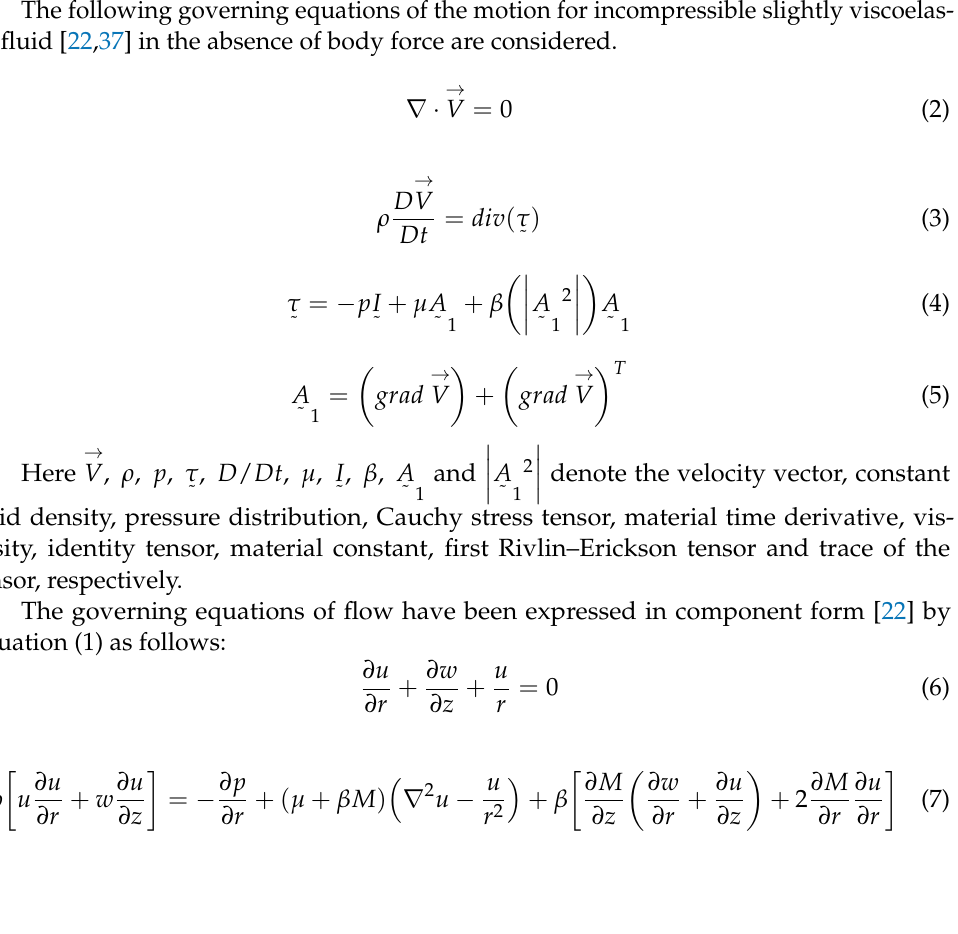
where u and w represent the radial and axial components of the velocity,